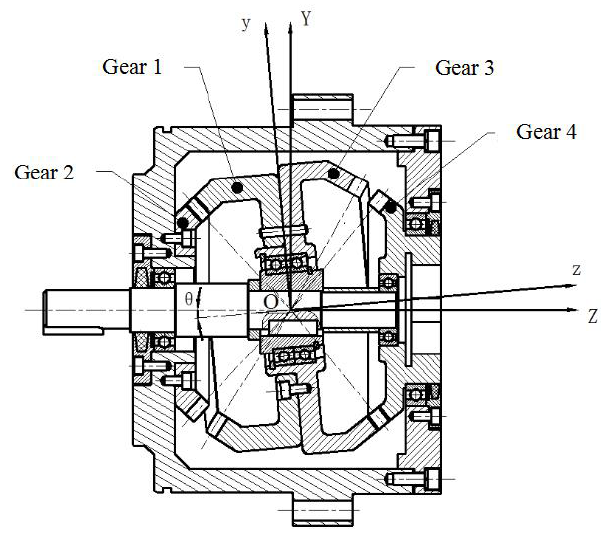
Figure 1. The structure of double-side meshing nutation